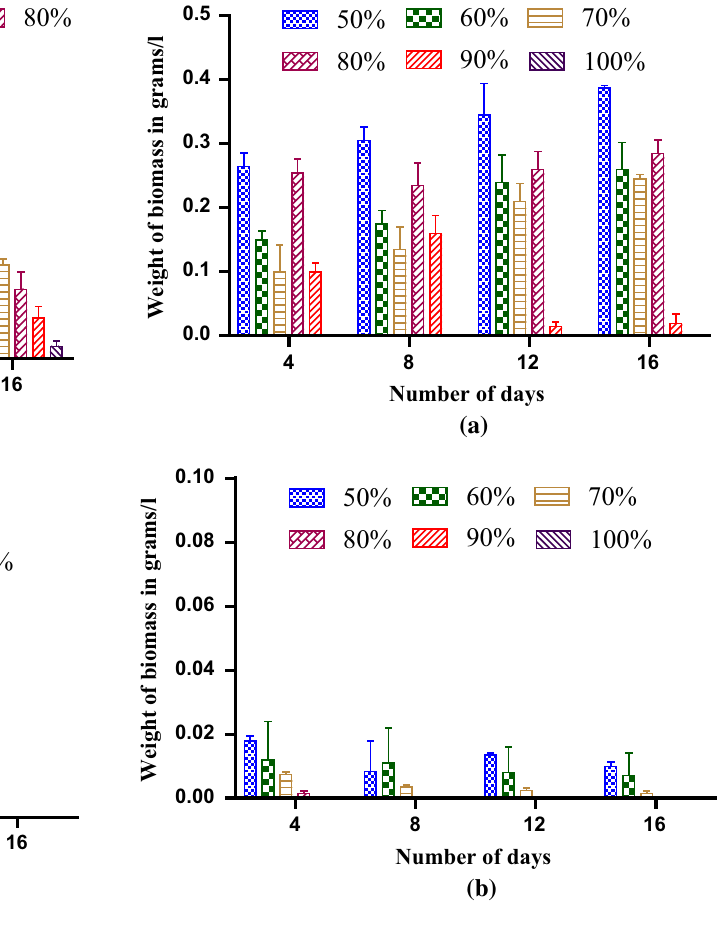
Fig. 5 Treatment of different tannery effluent concentration from Walajapet by a Chlorella sp . SRD3 and b Oscillatoria sp.